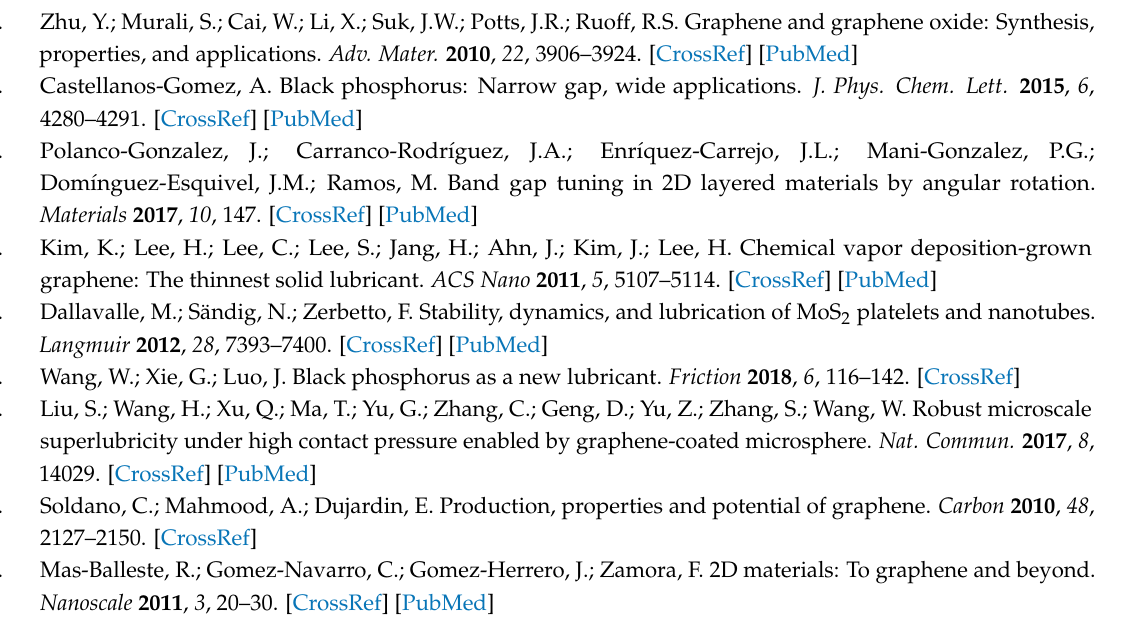
Figure S1: The force-displacement (FN(d)) curve for the indentation process of the freestanding BP monolayer at different indentation speed; Figure S2: ( a – d ) side view of freestanding model during the indentation process, and Figure a, b, c, d correspond to point A, B, C, D in Figure 2a of the manuscript respectively. ( e - h ) cutaway view of Pt(111)-supported model during the indentation process, Figure e, f, g, h correspond to point A, B, C, D in Figure 3a of the manuscript